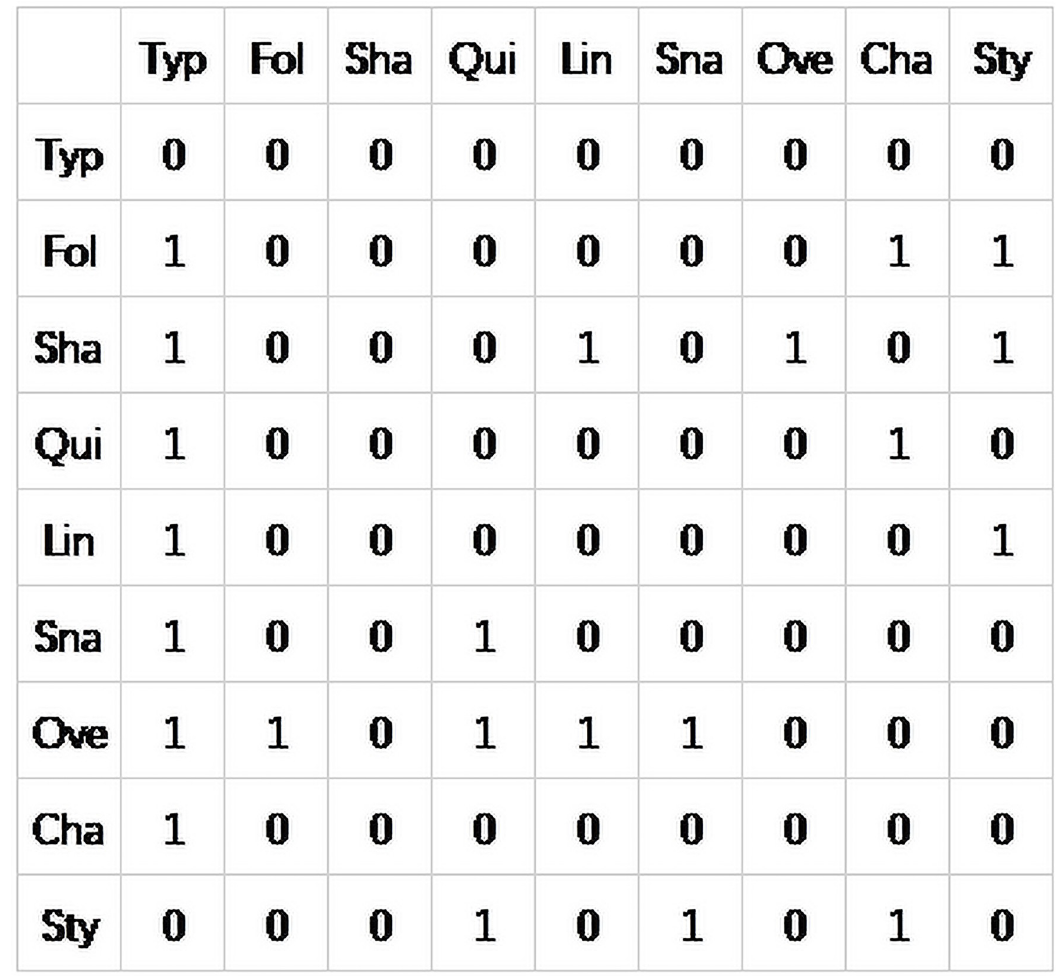
Fig 6. DAG structure